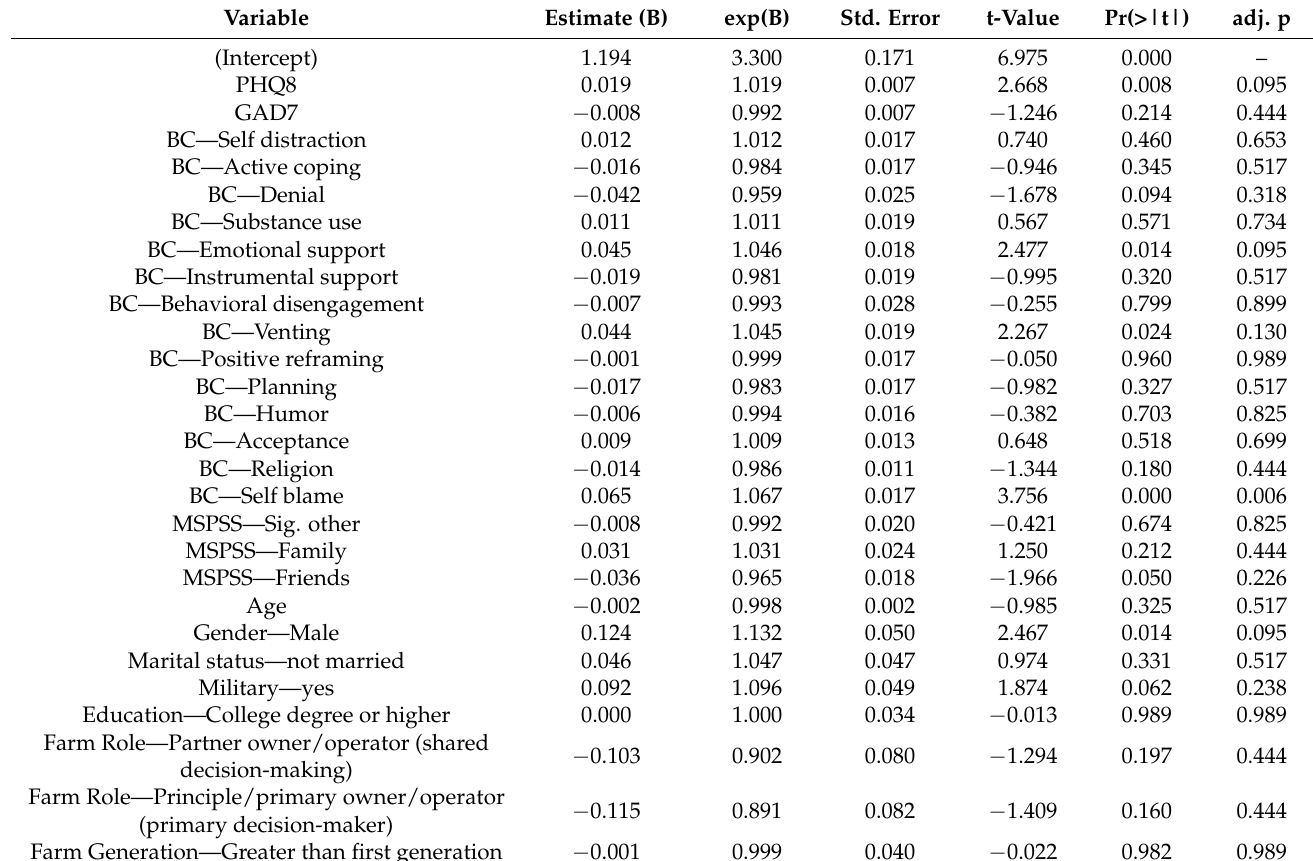
Table 4. Model 2: Multiple linear regression model to analyze associations with suicide risk, removing the 9th item of the